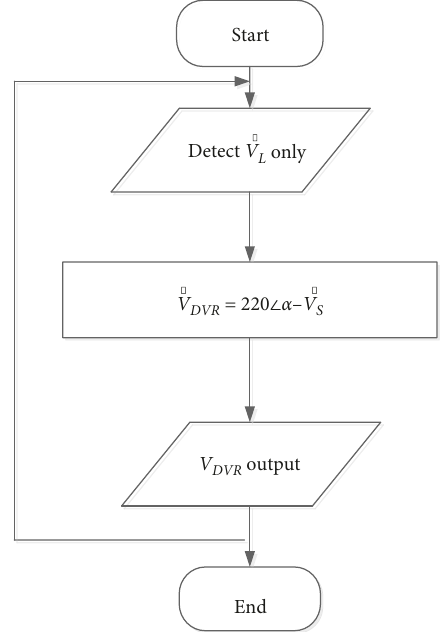
Figure 6: Flow chart of virtual comparison strategy of DVR